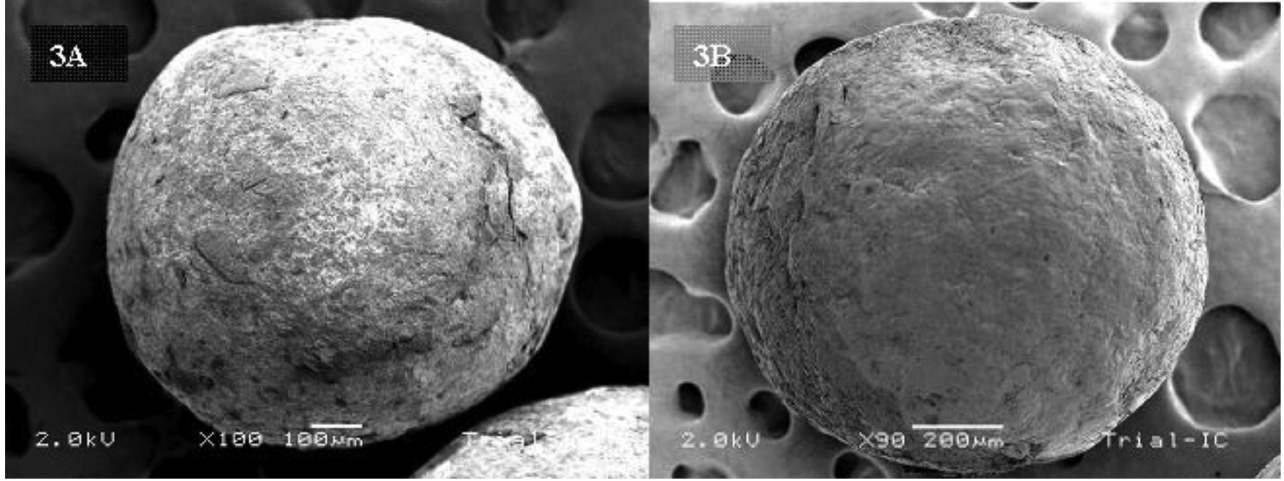
FIGURE 3 - A. Scanning electron micrographs of pellets prepared using sodium alginate as polymer. B. Calcium chloride-treated